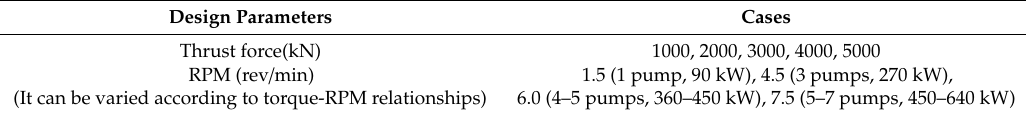
Table 3. TBM operational parameters applied in various test